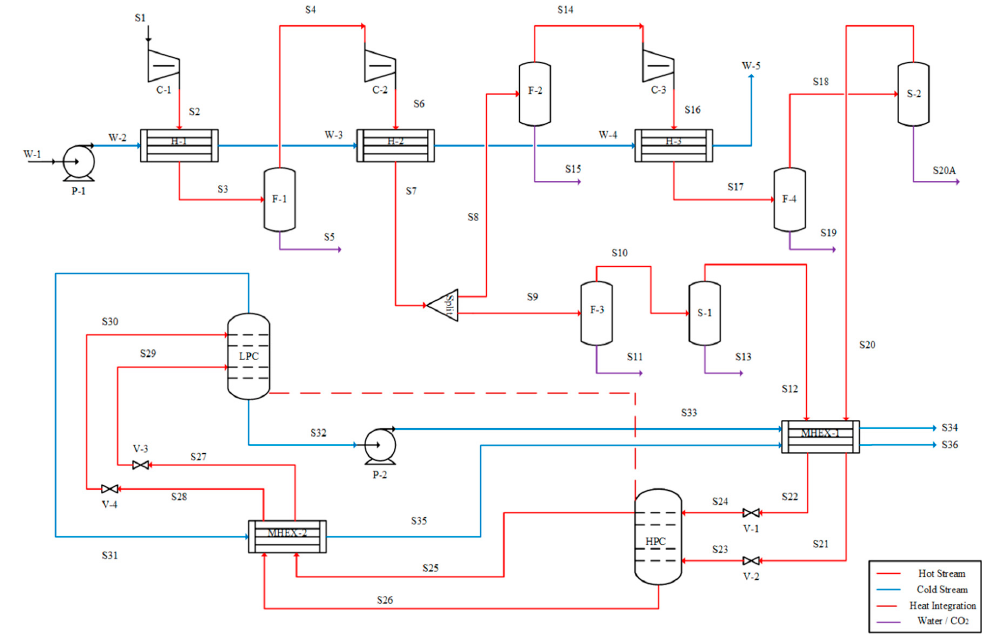
Figure 1. Process flow diagram of the air separation unit (ASU) configuration C1. Table 1. Steady-state simulation results for the ASU configuration C1.